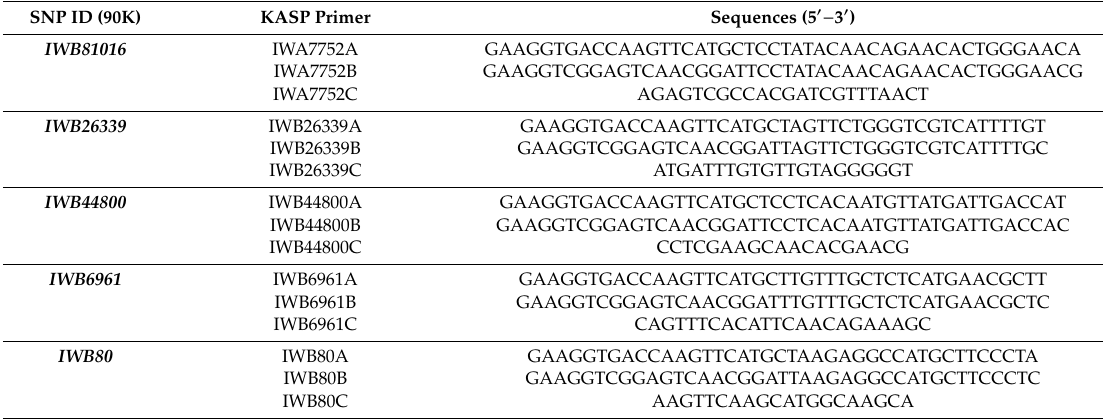
Table 6. Primer sequences of KASP markers for detecting the major stripe rust resistance QTL, QYrPI181410.wgp-4BL , from PI 181410 among 158 wheat cultivars or breeding